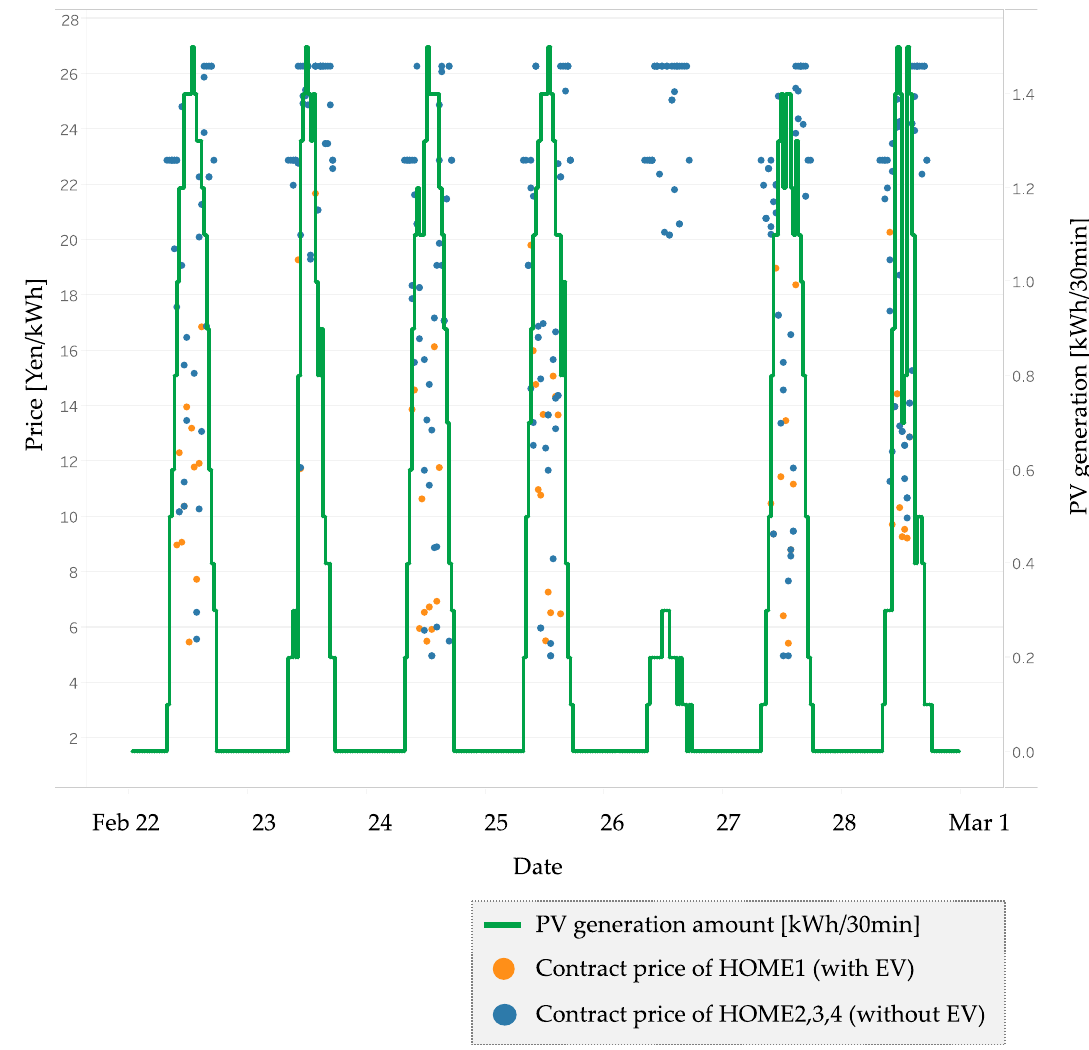
Figure 5. Contracted price by user and power generation.